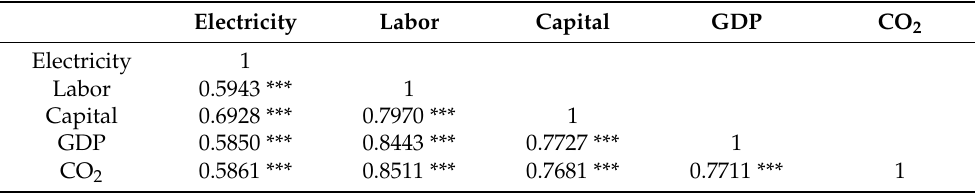
Table 3. Correlation matrixes of inputs and outputs.